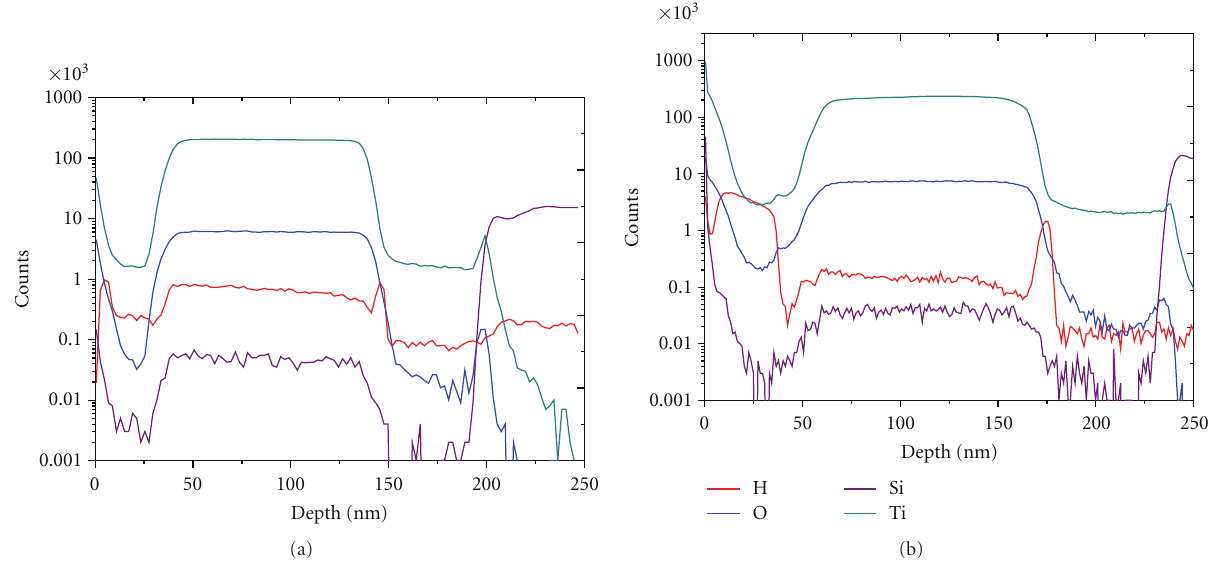
Figure 7: SIMS profiles for the sample Ti/TiO 2 /Ti/Si before (a) and after (b) hydrogen charging.